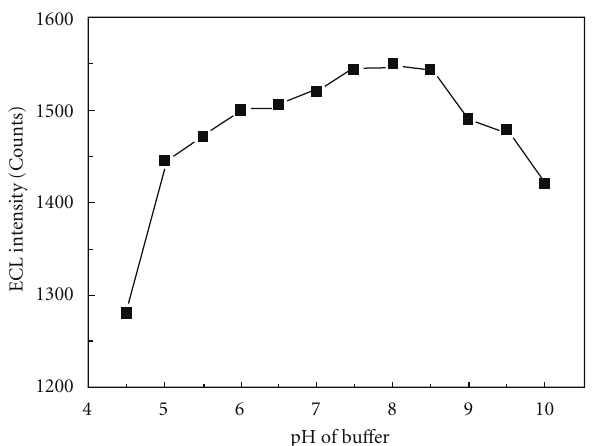
Figure 5: E ff ect of detection potential on ECL intensity: other conditions, the same as in